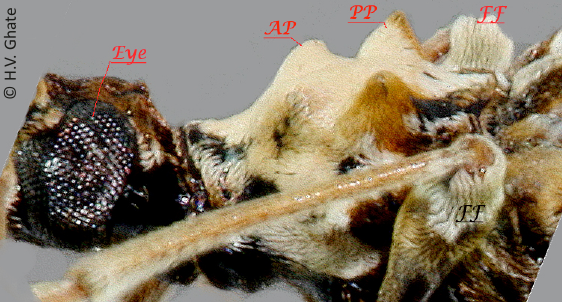
Image 6. Lateral view of prothorax of Apiocephalus to show e positions of anterior and posterior pair (AP and PP, respectively) of a t tubercles on the disc; FF marks indicate front femora. G h V . H . ©